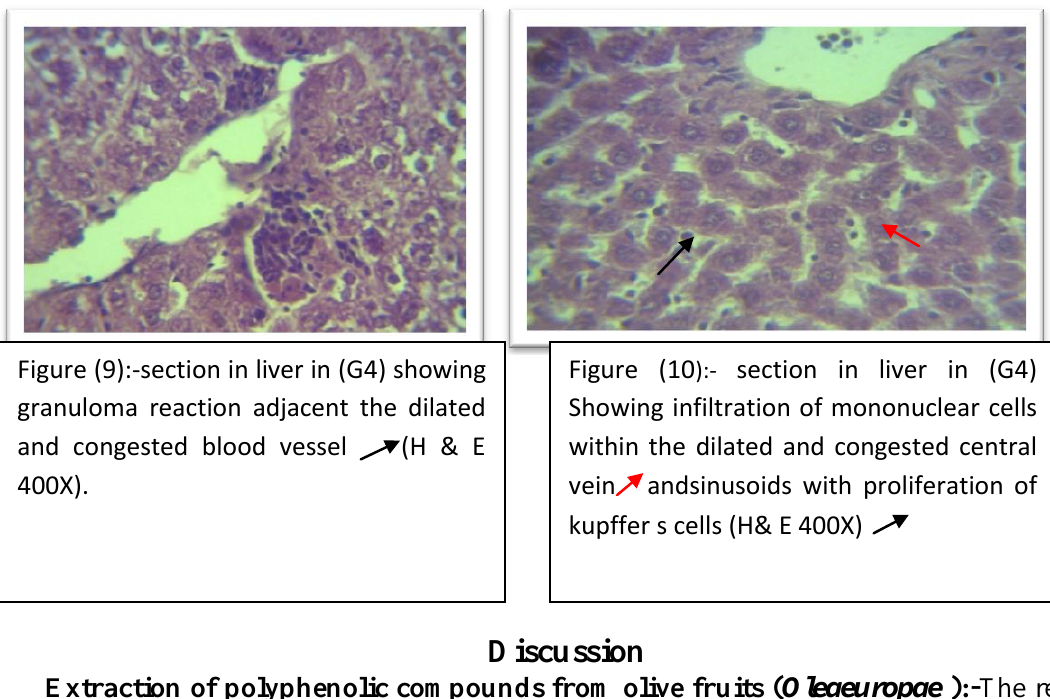
Figure (10 ):- section in liver in (G4) Showing infiltration of mononuclear cells within the dilated and congested central vein andsinusoids with proliferation of kupffer s cells (H& E